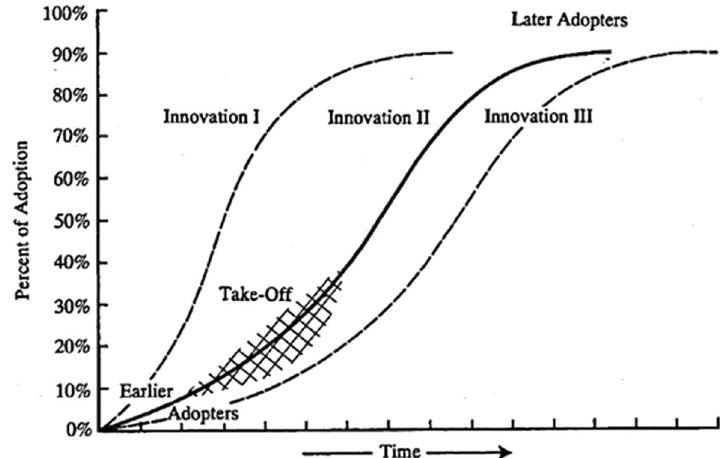
Fig. 1 Rogers’ S-shaped adoption curve (Rogers 2003)